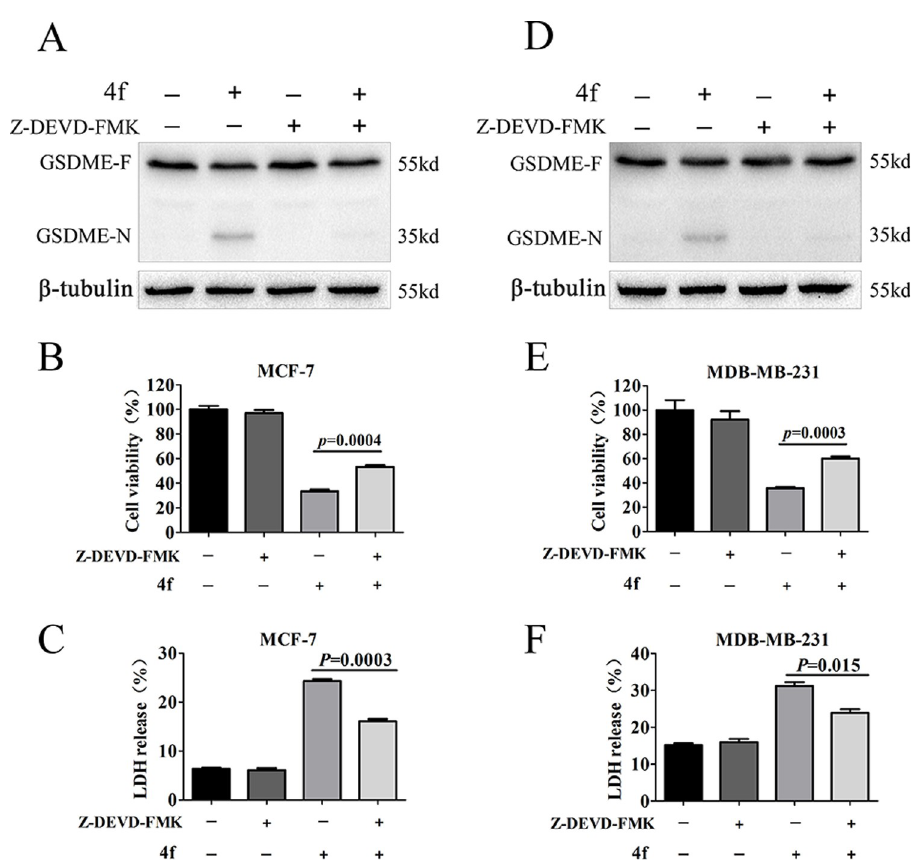
Fig 8. z-DEVD-FMK reduces the cleavage of GSDME. (A, D) Western blotting analysis of full-length GSDME (GSDME-F) and GSDME-N terminal (GSDME-N) in MCF-7 and MDA-MB-231 cells treated by 4f (5 μ M) in the presence or absence of z-DEVD-FMK (50 μ M). (B, E) Cell viability analysis by CCK8 kit. (C, F) LDH release was measured using LDH cytotoxicity assay kit. All the data repeated for three times.